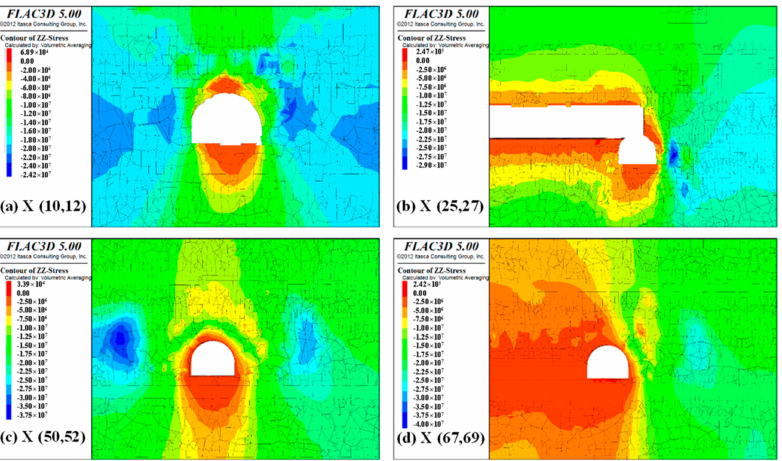
Figure 17. Z − direction stress distribution of the four monitoring areas after excavation of head chamber in belt roadway.